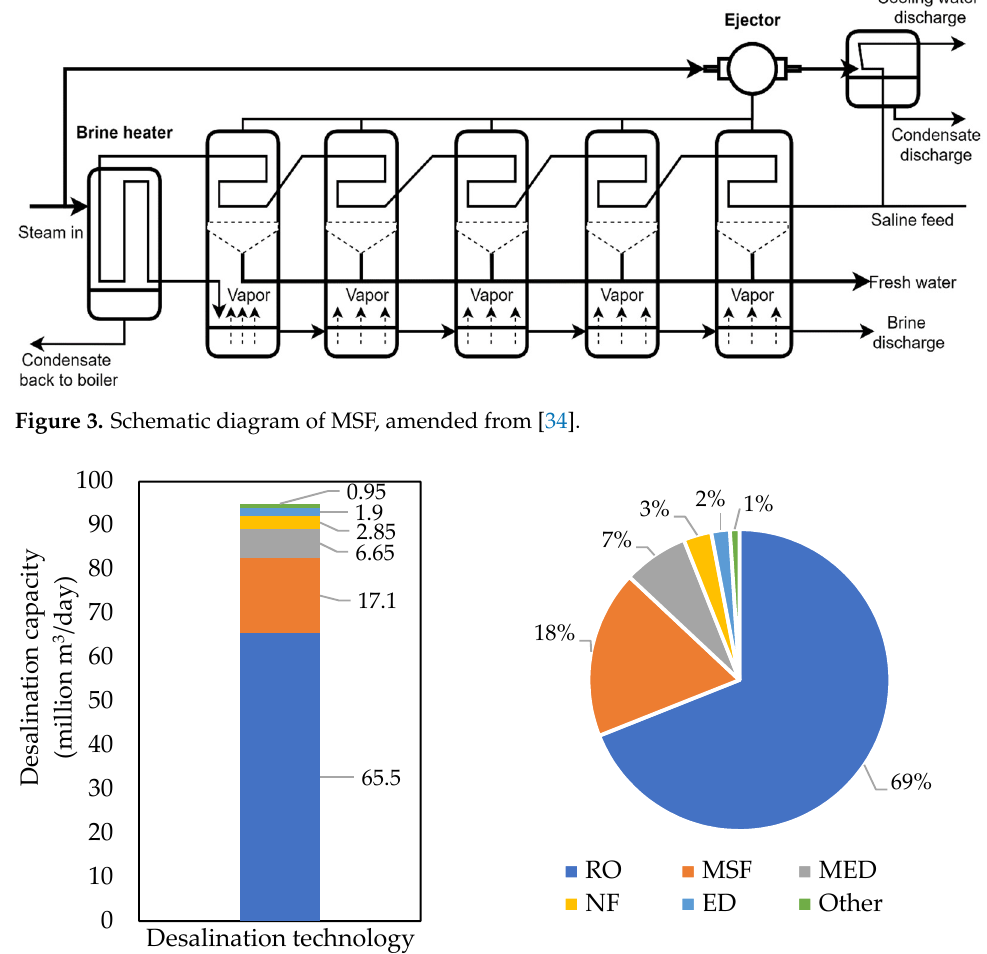
Figure 3. Schematic diagram of MSF, amended from [34].